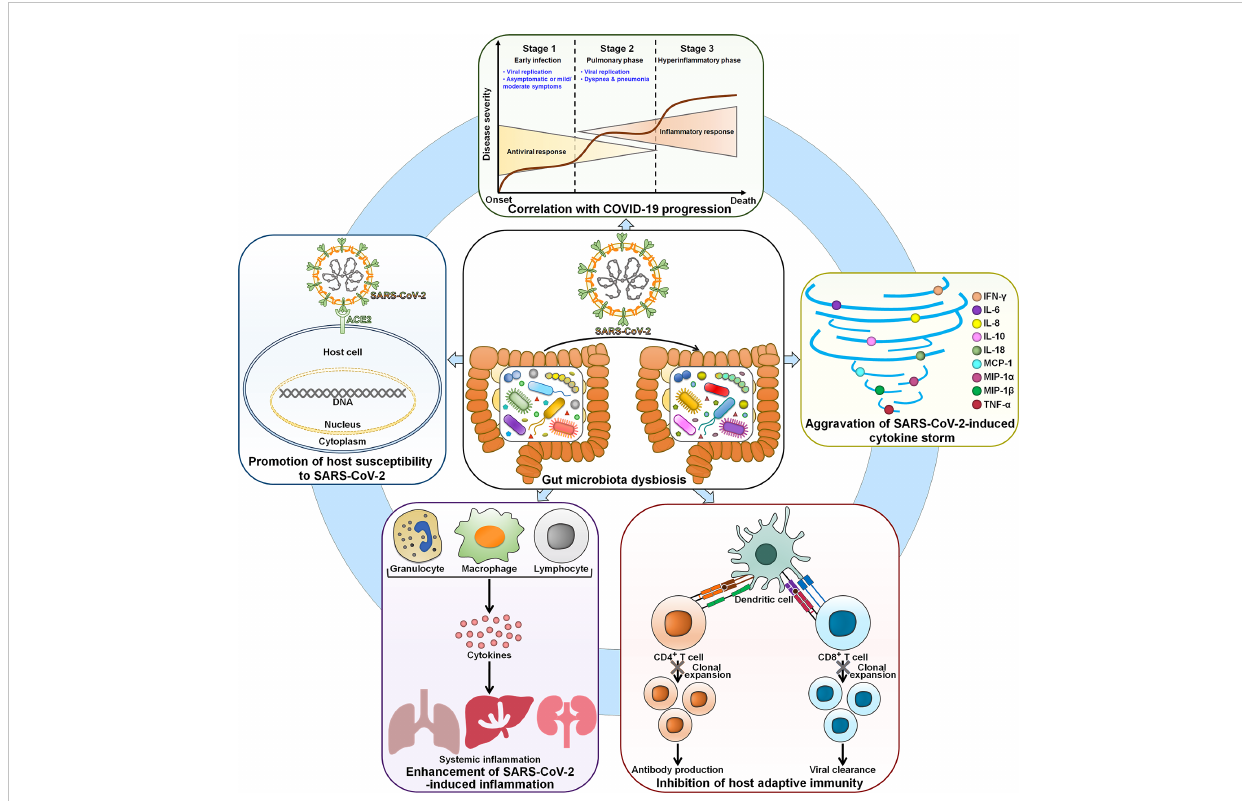
FIGURE 2 The involvement of dysbiotic gut microbiota in COVID-19 physiopathology. Gut microbiota affects the susceptibility of host cells to SARS-CoV-2 infection. SARS-CoV-2-induced gut microbiota perturbation contributes to COVID-19 deterioration. Thus, the gut microbiota signature is closely associated with clinical outcomes in COVID-19 patients. In terms of mechanism, gut microbiota exacerbates SARS-CoV-2-induced cytokine storm and leads to hyperin fl ammation. Moreover, gut microbiota is capable of abrogating host adaptive immune responses by inhibiting CD4 + T and CD8 + T cell expansion. SARS-CoV-2, severe acute respiratory syndrome coronavirus 2; ACE2, angiotensin-converting enzyme 2; IFN- g , interferon- g ; IL-6, interleukin-6; IL-8, interleukin-8; IL-10, interleukin-10; IL-18, interleukin-18; MCP-1, monocyte chemoattractant protein-1; MIP-1 a , macrophage in fl ammatory protein-1 a ; MIP-1 b , macrophage in fl ammatory protein-1 b ; TNF- a , tumor necrosis factor- a